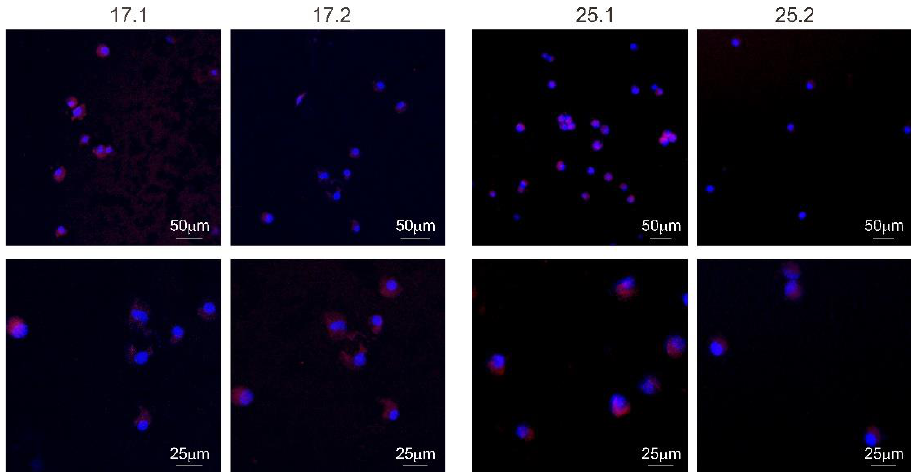
Figure 9. The number of nuclei per area visualized on the surface of biocomposites: ( a ) 17.1 and 17.2; ( b ) 25.1 and 25.2 after 5 days of incubation. The mean ± SD number of cell nuclei visible on at least 3 fields was counted. The 17.1 material constitutes the reference for 17.1, whereas 25.1 a reference for 25.2. The control material was set as 100%.